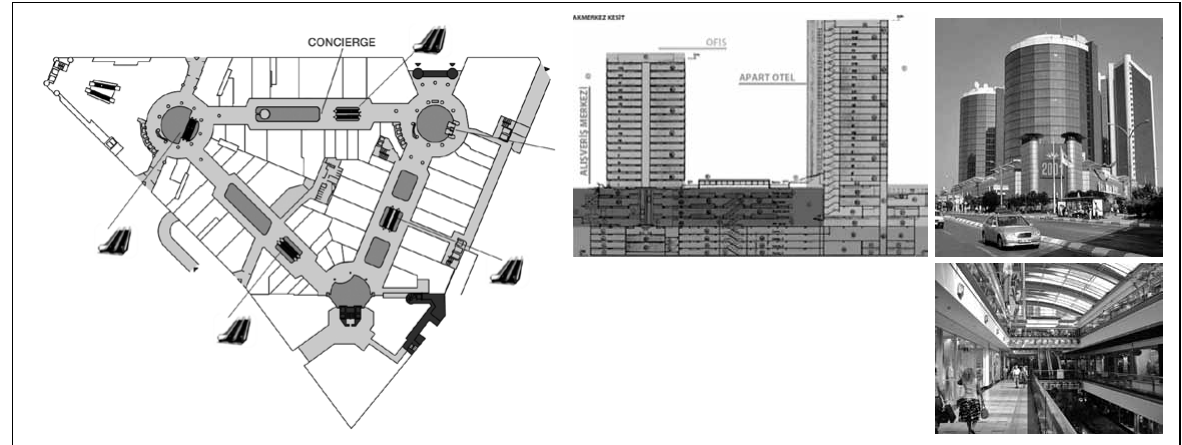
fig. 4. akmerkez Shopping Mall Plan-Exterior-Interior,